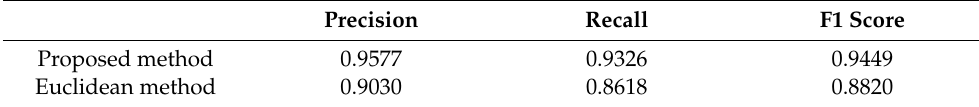
Table 2. Evaluation